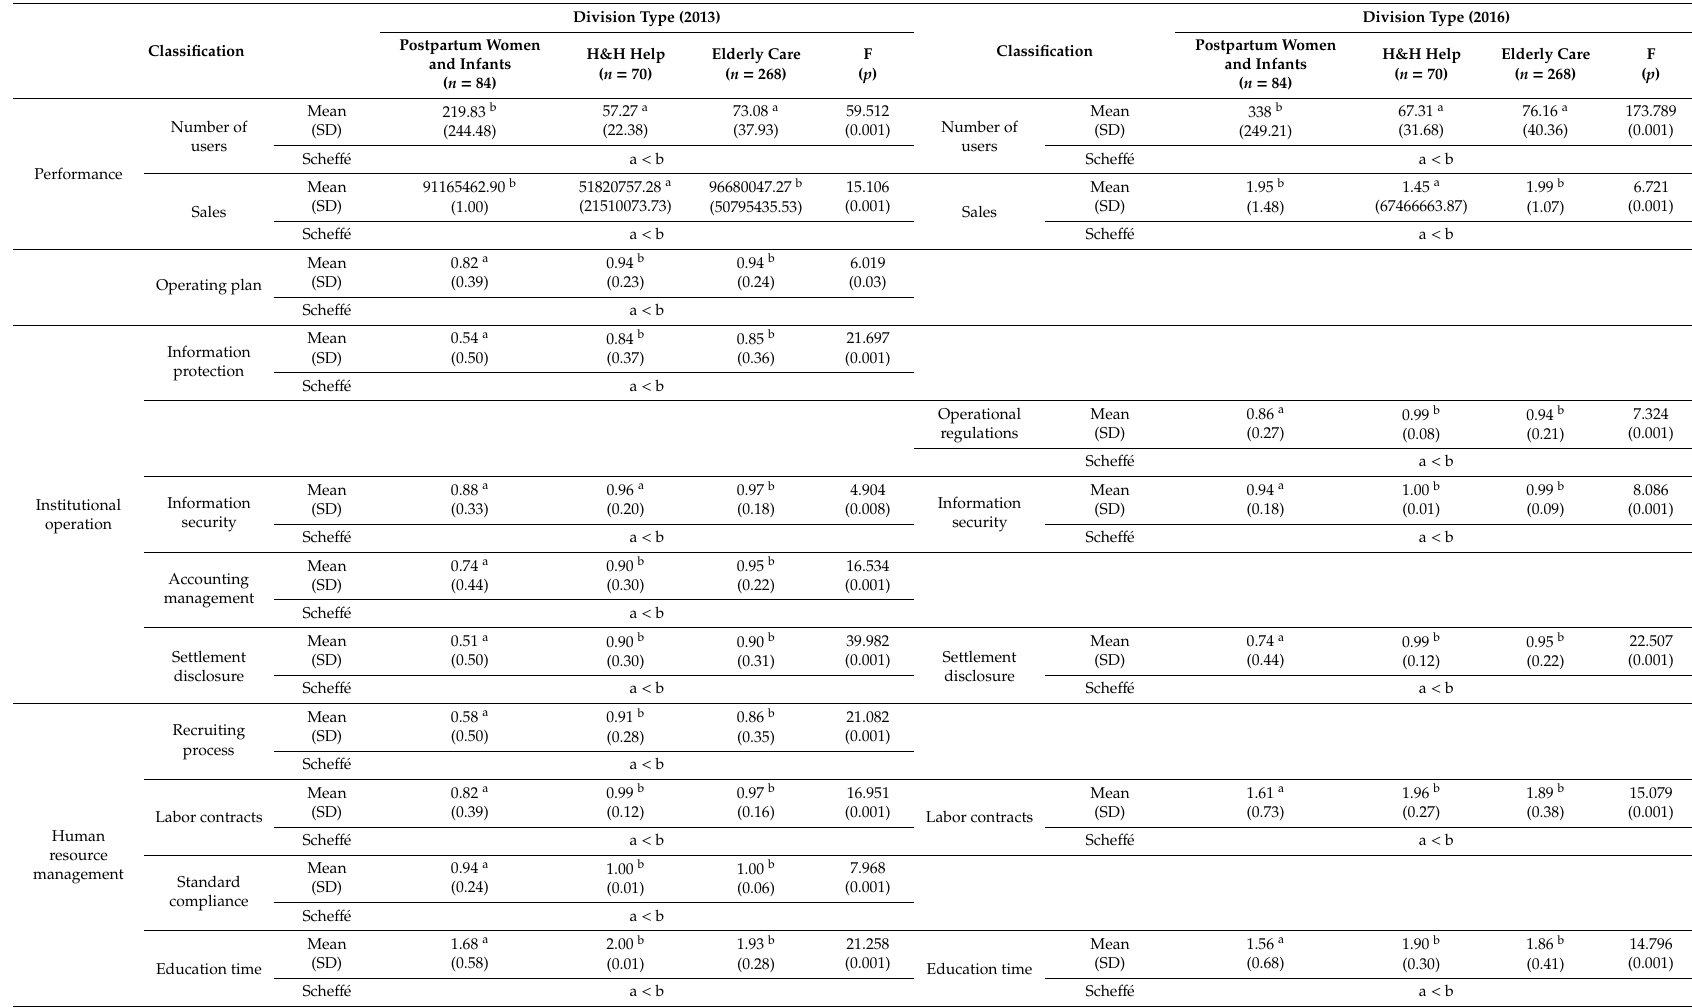
Table 3. Di ff erence analysis by service type in 2013 and